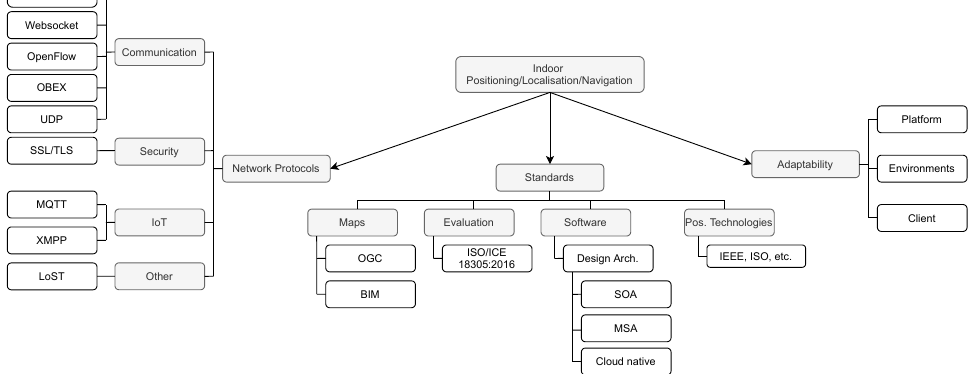
Figure 6. Network protocols, standards and adaptability to new environments.